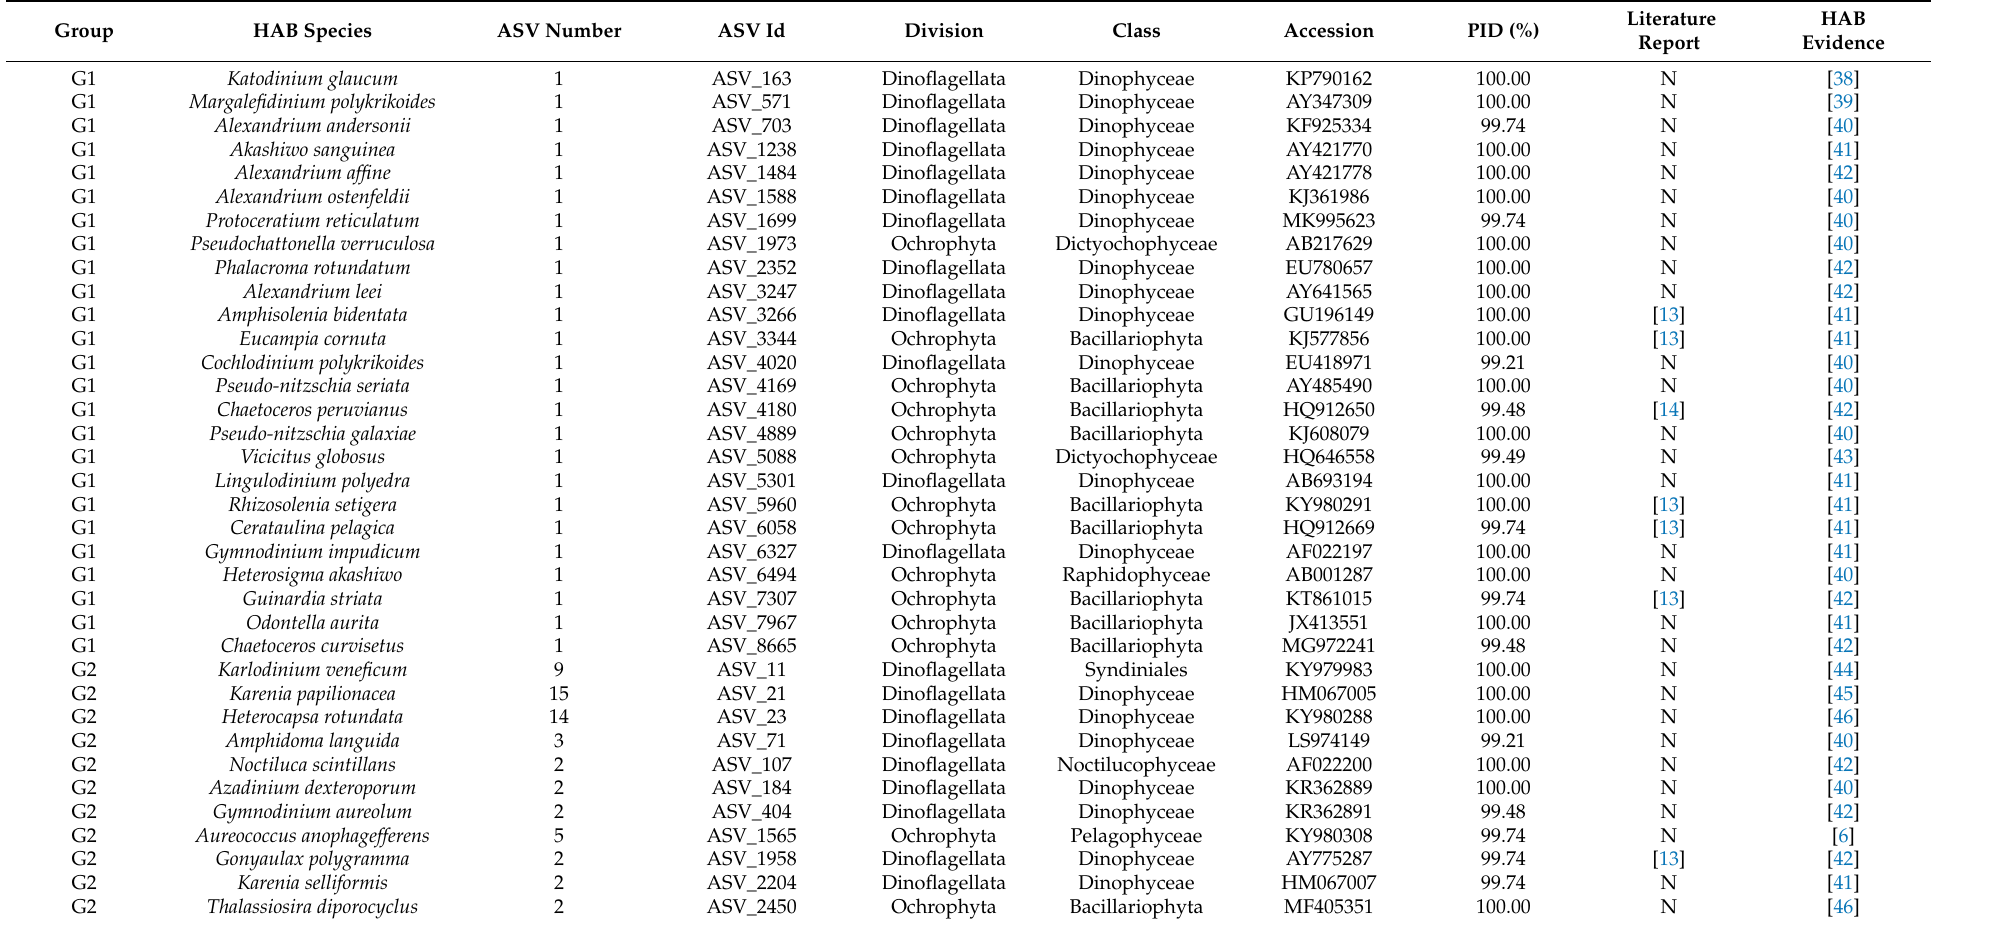
Table 1. List of 36 HAB species in this